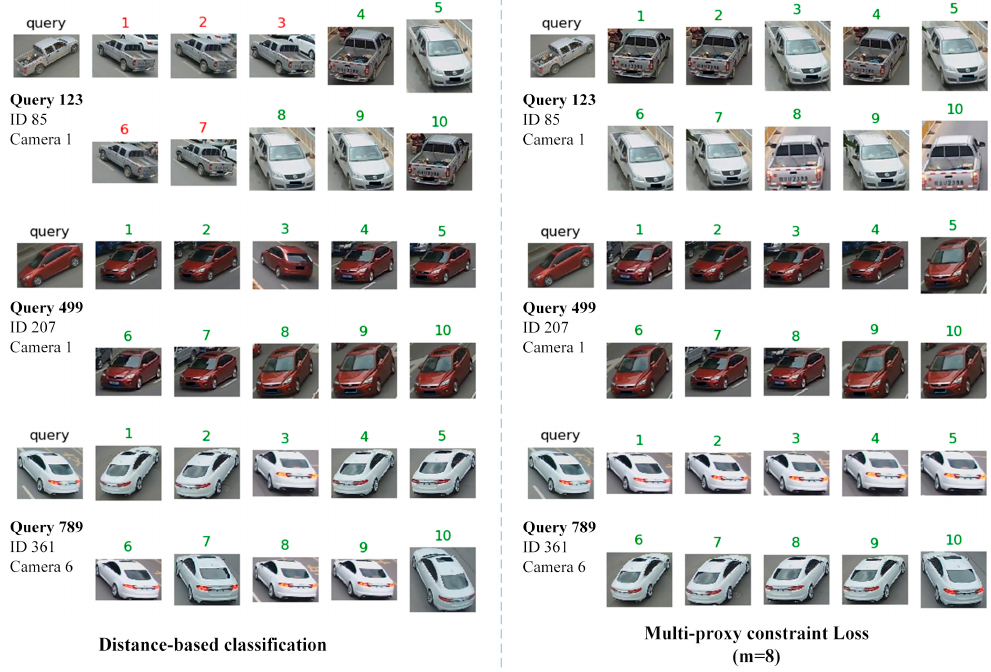
Figure 5. The Top-10 retrieval results on VeRi-776 dataset. The left-most images labeled ‘query’ are the query images. The two columns are the results of distance-based classification and multi-proxy constraint loss (m = 8). The ground-truth is labeled with green number. The wrong images will be labeled with red numbers.